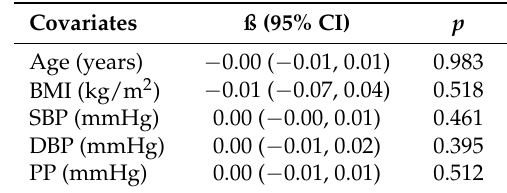
Table 5. Meta-regressions of the PWV and total dairy products consumption by age, body mass included